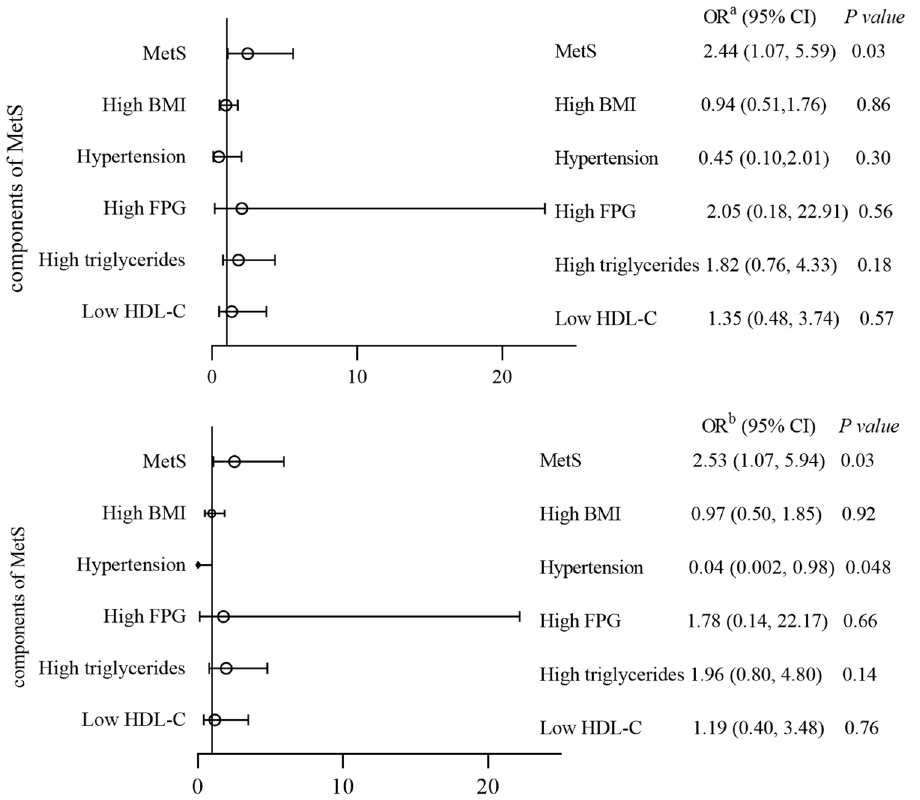
Figure 2. Relationship between depressive symptoms and metabolic components with or without multivariate adjustment in participants. ( a ) Crude model; ( b ) adjusted for education level, marital status, smoking, alcohol consumption, tea consumption, physical activity and heart disease. MetS metabolic syndrome, BMI body mass index, FPG fasting plasma glucose, HDL high-density lipoprotein cholesterol, OR odds